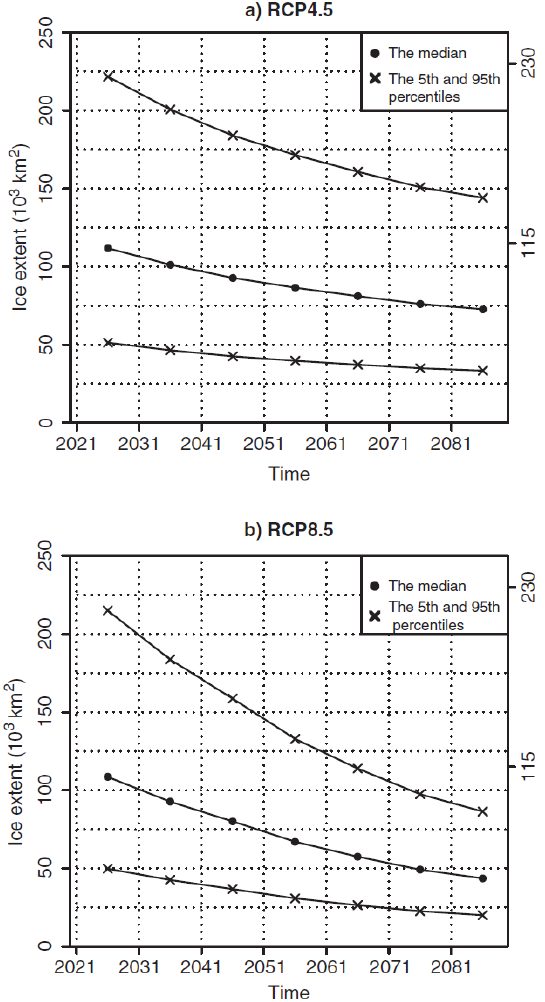
Figure 29. Median, 5th, and 95th percentiles of the annual maxi- mum sea ice extent of the Baltic Sea (in 10 3 km 2 ) estimated from 28 CMIP5 models. The right-hand side vertical axis shows the up- per class limits for mild and average ice winters. (a) RCP4.5. (b) RCP8.5. Source: Luomaranta et al., 2014; their Fig. 5 is distributed under the terms of the Creative Commons CC-BY 4.0 License (http://creativecommons.org/licenses/by/4.0/, last access: 17